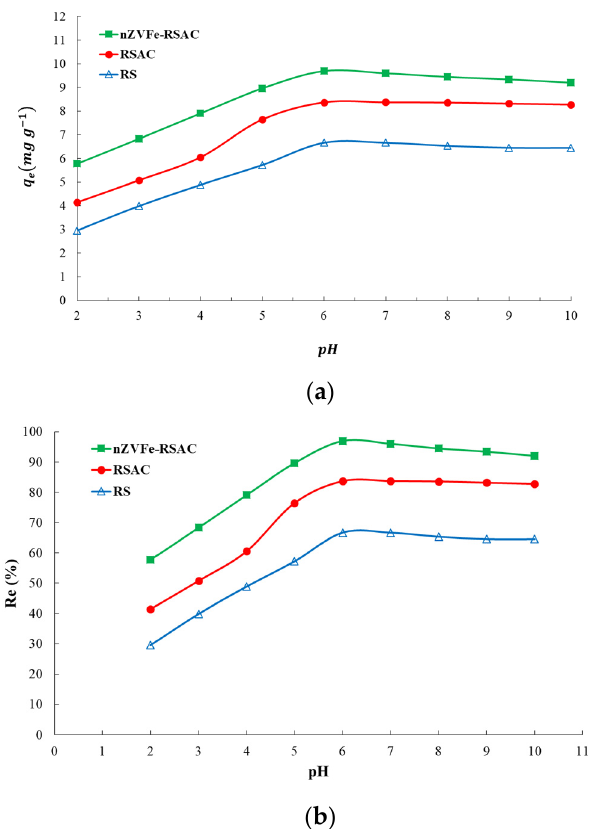
Figure 4. Pb(II) adsorption capacity ( a ) and removal efficiency ( b ) of RS, RSAC, and nZVFe–RSAC at different pH levels .